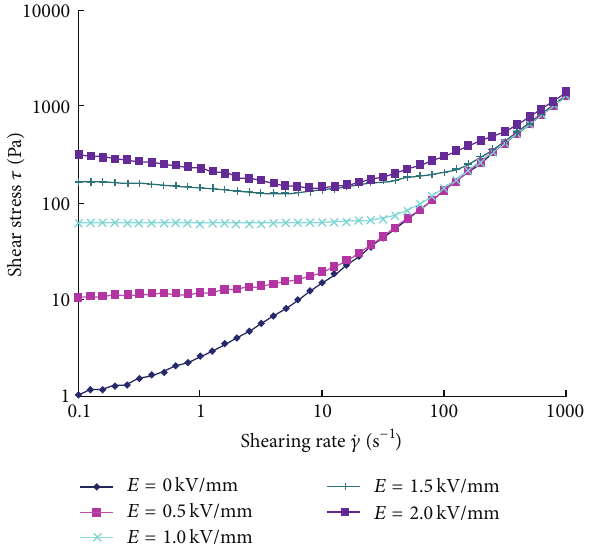
Figure 2: Characteristic curve of ER fluids.